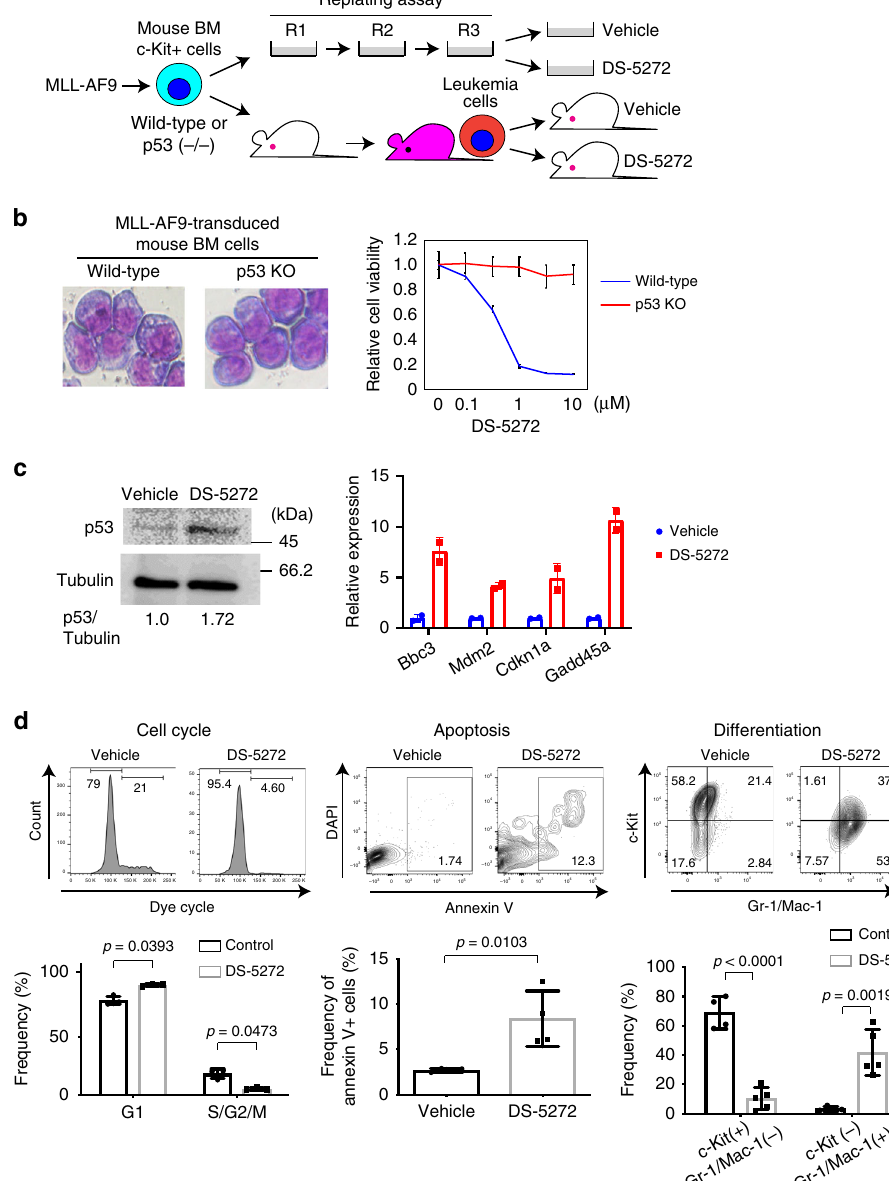
Fig. 1 DS-5272 activates p53 and inhibits the growth of MLL-AF9 cells both in vitro and in vivo. a Experimental scheme used in b – d . Bone marrow c-Kit + cells derived from wild-type or p53-de fi cient mice were retrovirally transduced with MLL-AF9. The cells were serially replated in vitro or directly transplanted into recipient mice to produce MLL-AF9 leukemia cells. b (left) Wright-Giemsa staining of wild-type and p53-de fi cient leukemia cells induced by MLL-AF9. Original magni fi cation, ×40. (right) Viability of cells treated with DS-5272 at indicated concentrations was measured by WST-8 assay. Data are normalized to vehicle control (0 μ M group), and are shown as mean ± s.d. c GFP + MLL-AF9 leukemia cells were collected from bone marrows of vehicle- or DS-5272-treated mice. Expression levels of p53 protein (left) and p53-target genes (right) were assessed by western blotting or qPCR, respectively. Band intensities of p53 and Tubulin were quanti fi ed with Multi Gauge (Science Lab), and the intensities of p53 relative to GAPDH are shown. d Cell-cycle status, apoptosis, and differentiation were assessed in GFP + MLL-AF9 leukemia cells derived from vehicle- or DS-5272-treated mice 24 h after treatment. Representative FACS plots (upper panels) and their quanti fi cation for three to four independent mice (lower panels). (Cell cycle_Vehicle: n = 3, DS-5272: n = 3, Apoptosis_Vehicle: n = 4, DS-5272: n = 4, Differentiation_Vehicle: n = 4, DS-5272: n = 5). Experiments were independently repeated at least three times. Student t -test. The numbers shown in upper panels indicate the percentage of cells within each gate. Data are shown as mean ± s.d. in lower